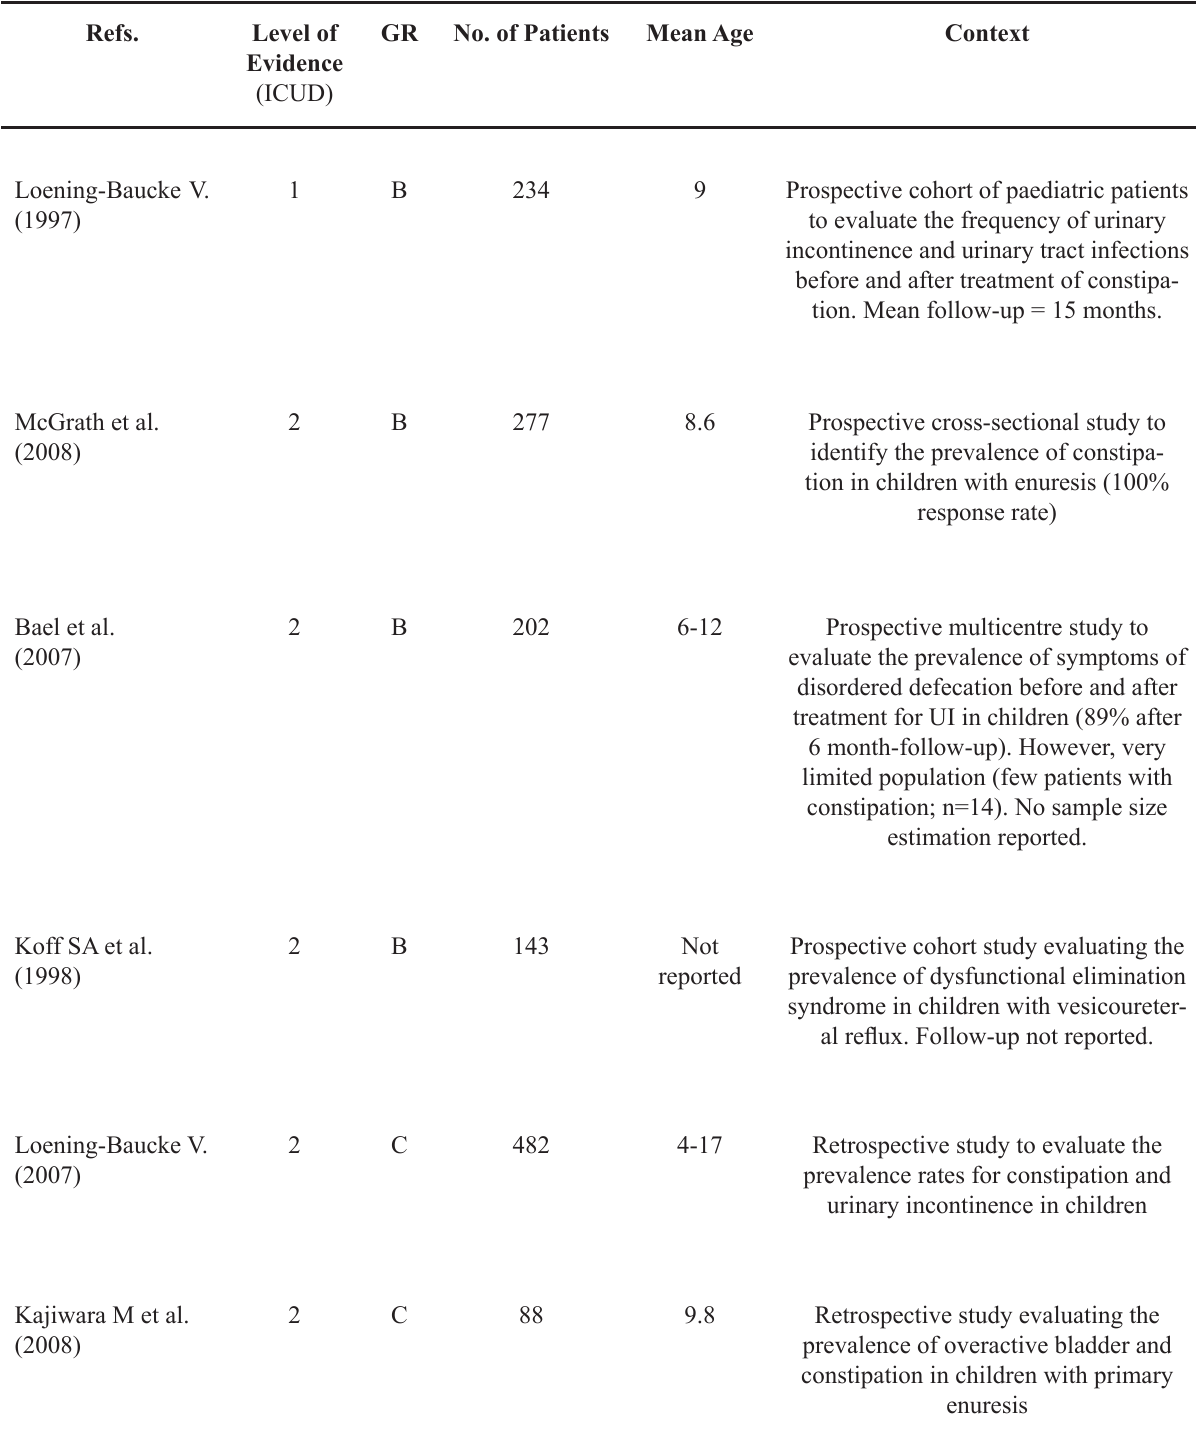
Table 3 – Literature data on constipation and LUTS in children.